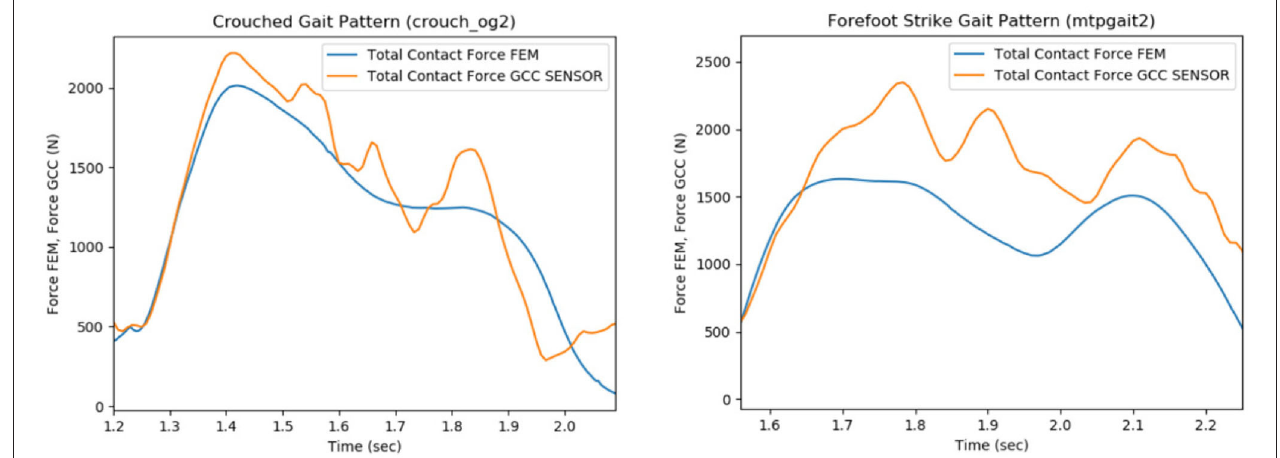
FIGURE 8 | Comparison of the total contact force values that were recorded from the sensor of the implant (e-Tibia, GCC data set), which were provided by the 6th GCC (indicated with orange), with the estimated articular forces through the analysis of the total knee replacement (TKR) finite element model (blue curves), during the patient’s crouch (crouch_og2, left plot) and forefoot strike (mtpgait2, right plot) gait patterns.